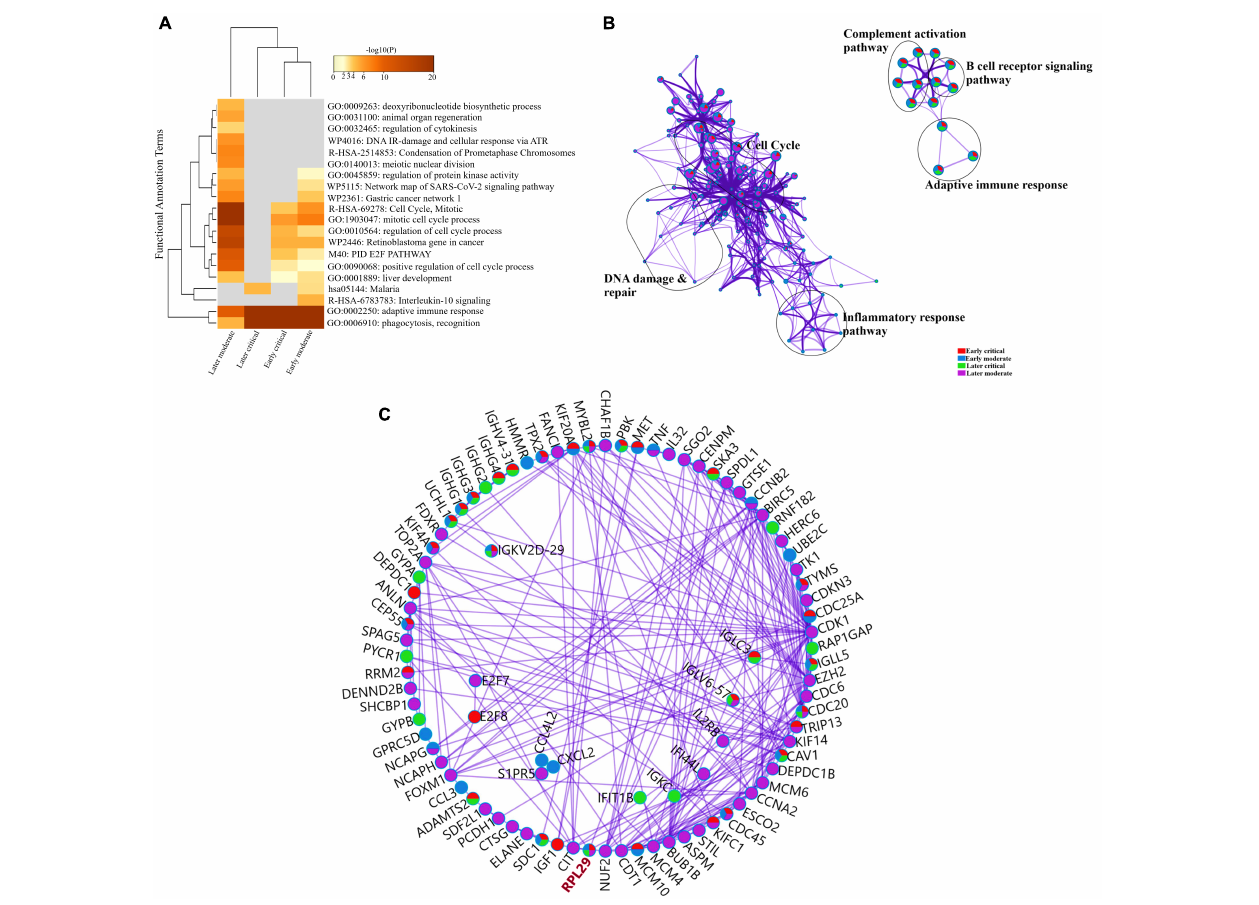
FIGURE 5 | Functional enrichment analysis of multiple DEGs from all SARS-CoV-2 infected groups. (A) Heat map displaying the top 20 enriched clusters for early and later moderate and critical patients using a distinct color scale to represent statistical significance using -log10(P). The functional annotation terms and their categories are M (canonical pathways), GO (Gene Ontology), WP (Wiki pathways), R-HSA (Reactome Gene Sets), and hsa (KEGG pathway). Gray color designates the lack of significance. (B) Enrichment network visualization of multiple DEG lists. Cluster labels representing the network name were added manually. The clustered network showed that processes such as the B-cell signaling pathway, cytokinesis, interleukin signaling pathway, and cell cycle are shared between the early and later moderate gene lists. (C) Interactome analysis of proteins between DEGs of each group. Each color code describes the gene identities in the four COVID-19